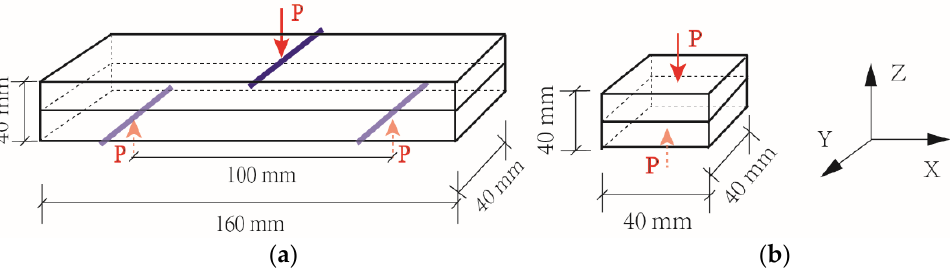
Figure 3. Loading in the Z direction. ( a ) Flexural load in printed objects. ( b ) Compressive load in printed objects.